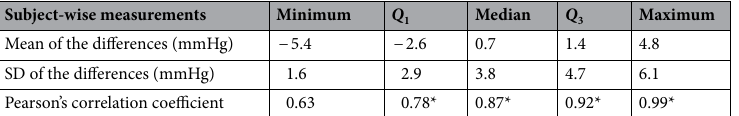
Table 3. Agreement between the EIT-derived and TTE-derived systolic pulmonary artery pressure estimates at the subject-wise level. For each subject, the mean and standard deviation (SD) of the paired differences between both methods was computed, along with Pearson’s correlation coefficient. The distributions over all participants are shown using the three quartiles ( Q 1 , median, and Q 3 ), and the range (minimal and maximal values). EIT electrical impedance tomography, TTE transthoracic echocardiography. *Significant at the 5% significance level ( P <